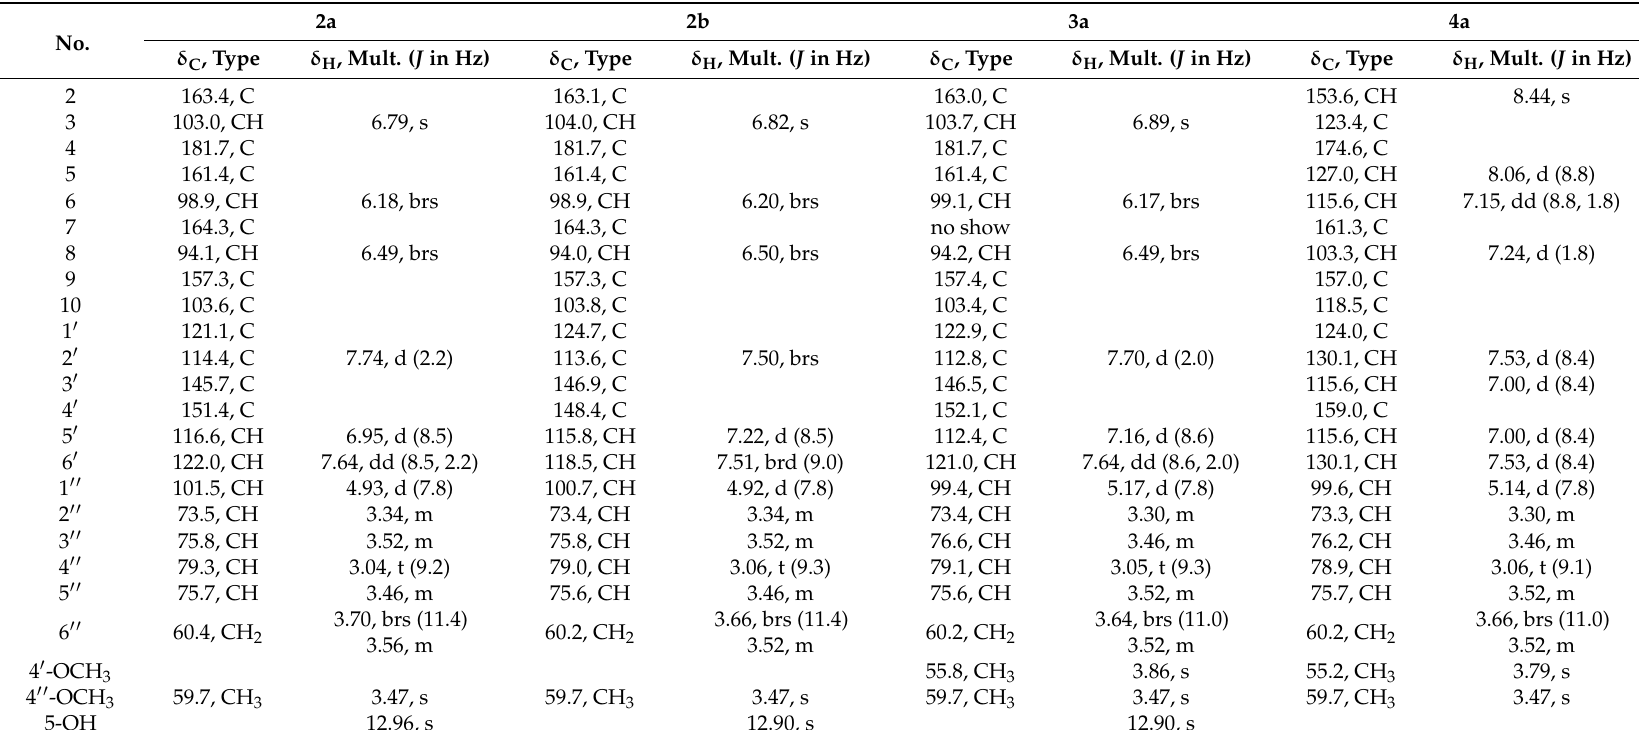
Table 2. 1 H- (600 MHz) and 13 C-NMR (150 MHz) Data of 2a , 2b , 3a and 4a in DMSO- d